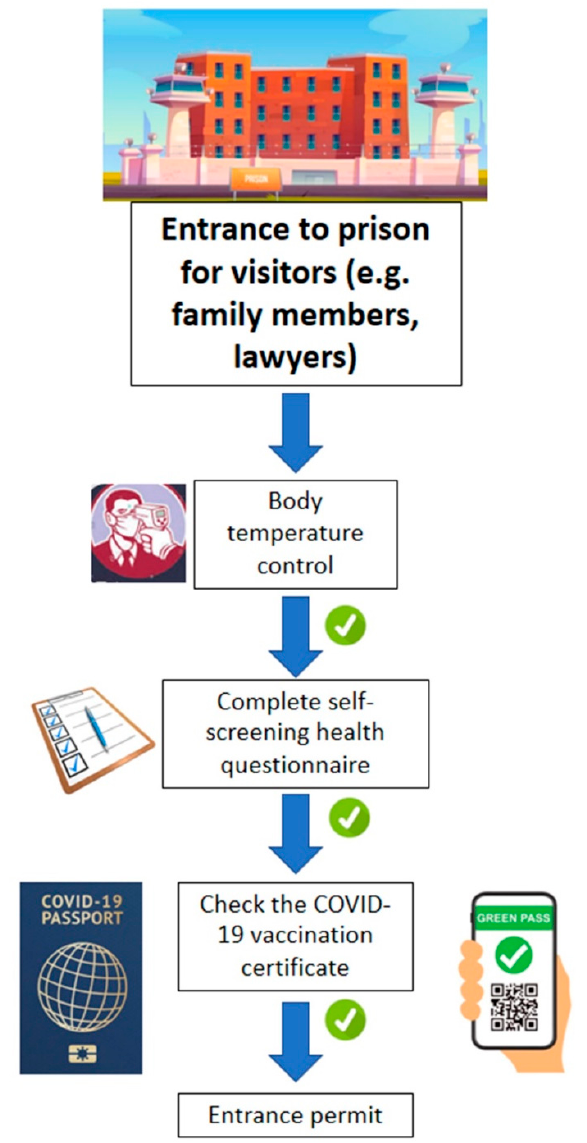
Figure 3. Prevention measures for COVID-19 for visitor in prisons.